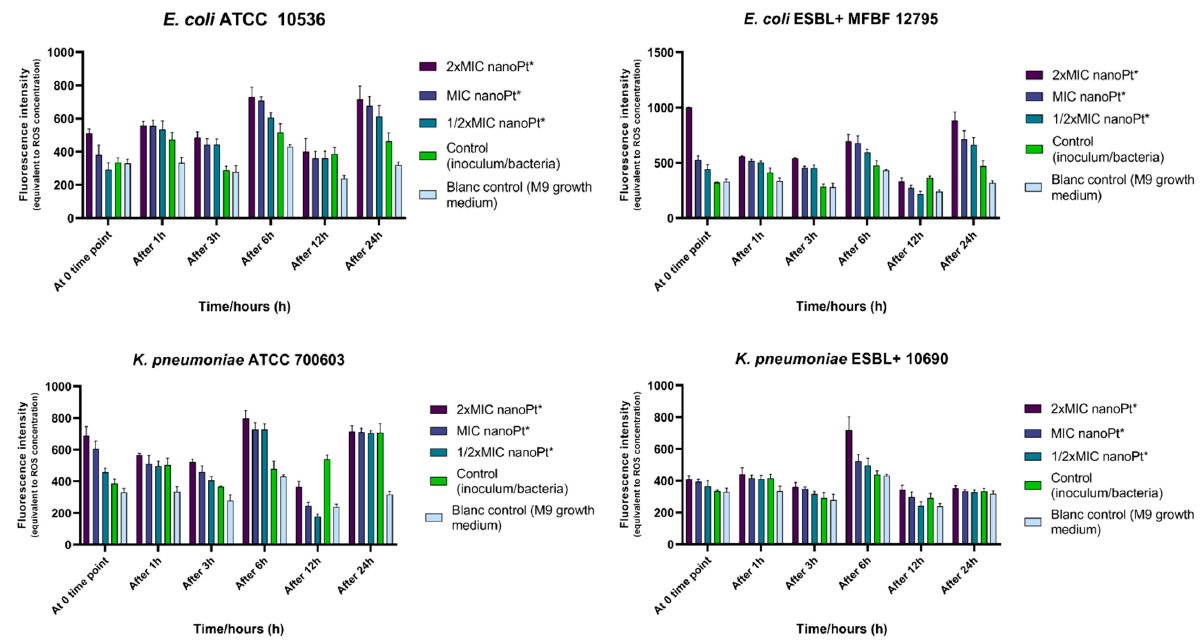
Figure 5. Interrelations of ROS concentrations in the extracellular compartments of all samples and time dependence for all tested bacterial strains. nanoPt*—platinum nanoparticles.